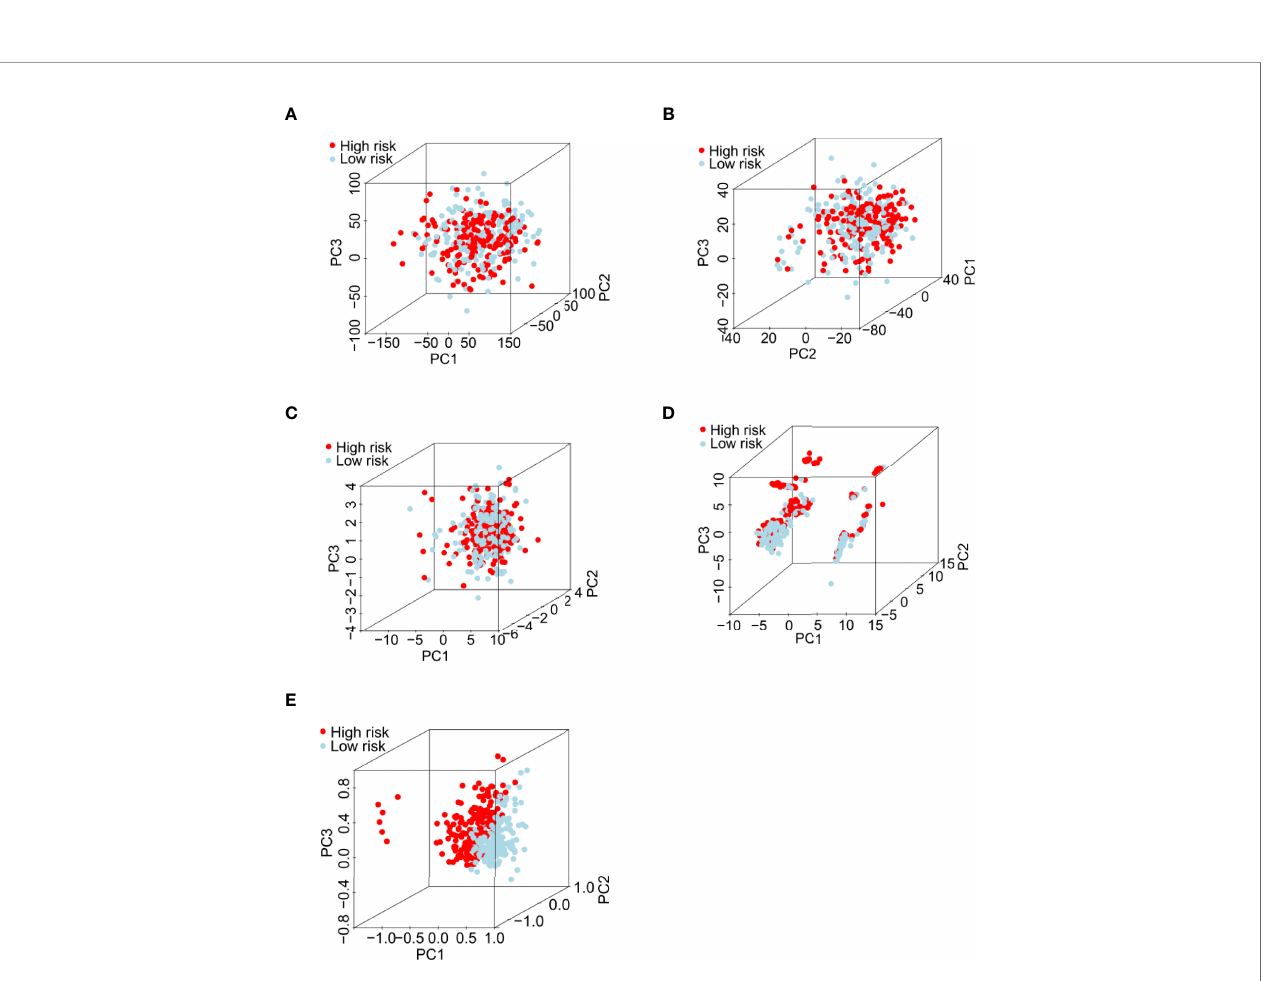
FIGURE 4 | Principal component analysis between the low- and high-risk groups in the entire set. (A) All RNA-seq data from the TCGA database. (B) Expression pro fi les of all coding genes. (C) Expression pro fi les of 26 writer-related genes. (D) Expression pro fi les of six writer-related lncRNAs. (E) Risk model based on the pro fi les of the six writer-related